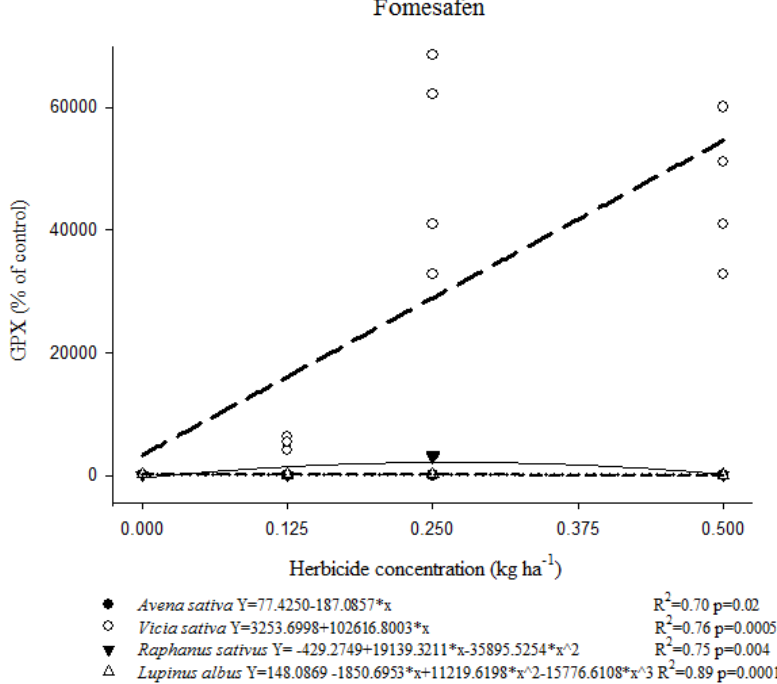
Figure 3 - Effect of fomesafen on Guaiacol peroxidase (GPX) activity in different crop